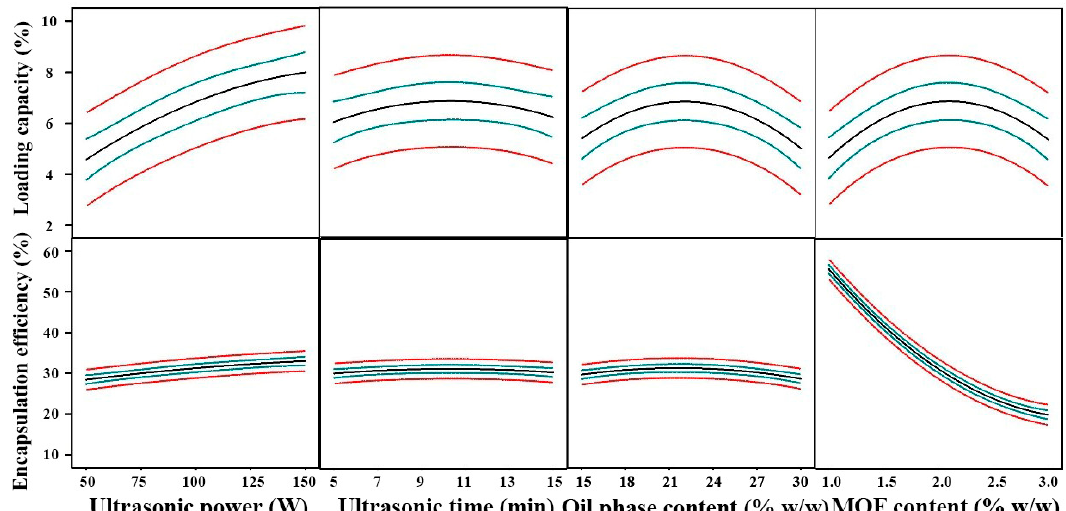
Figure 2. Prevision profiler’s outputs after maximization of the desirability function for LC and EE: Optimum emulsion preparation conditions are given, while curves show how changes of factors’ levels affect the response. Green lines indicate 95% confidence intervals and red lines indicate model predictions.